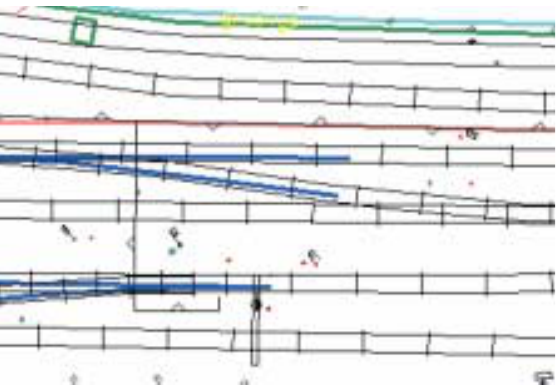
Fig 3. Railways with inserted new points